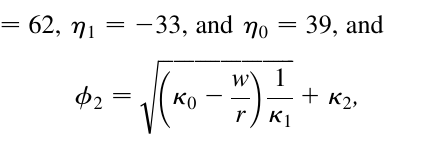
FIG. 31. (Color) Two solutions for setting to zero B angular width of the inner and outer sector (cid:12) ratio w=r